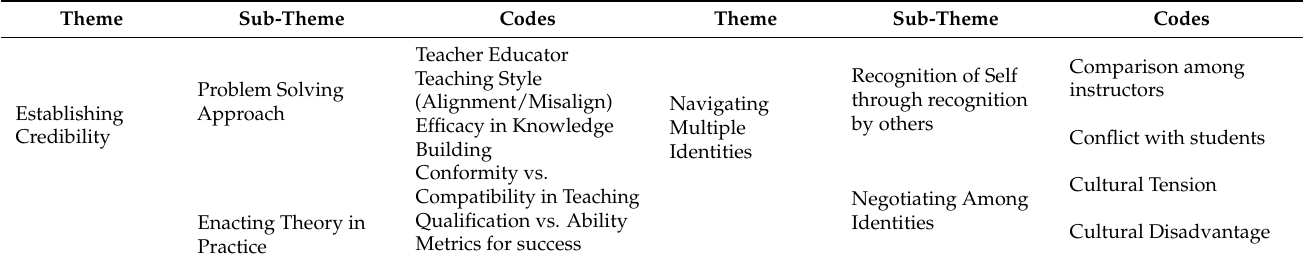
Table 2. Examples of Themes and